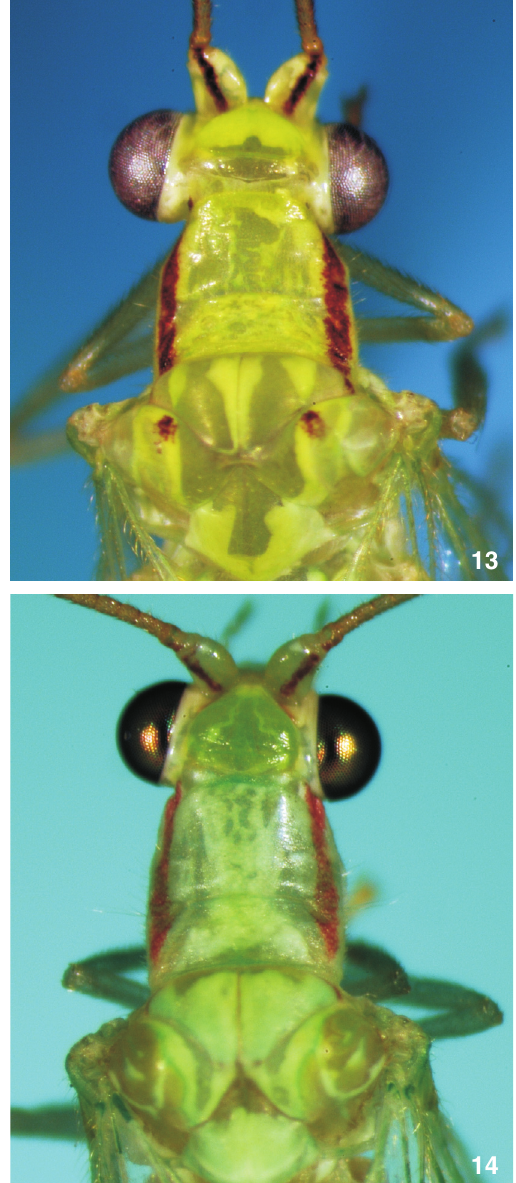
Figuras 13-14. Variações no padrão de manchas tegumentares de fêmeas e machos de C. caligata : (13) adulto com manchas